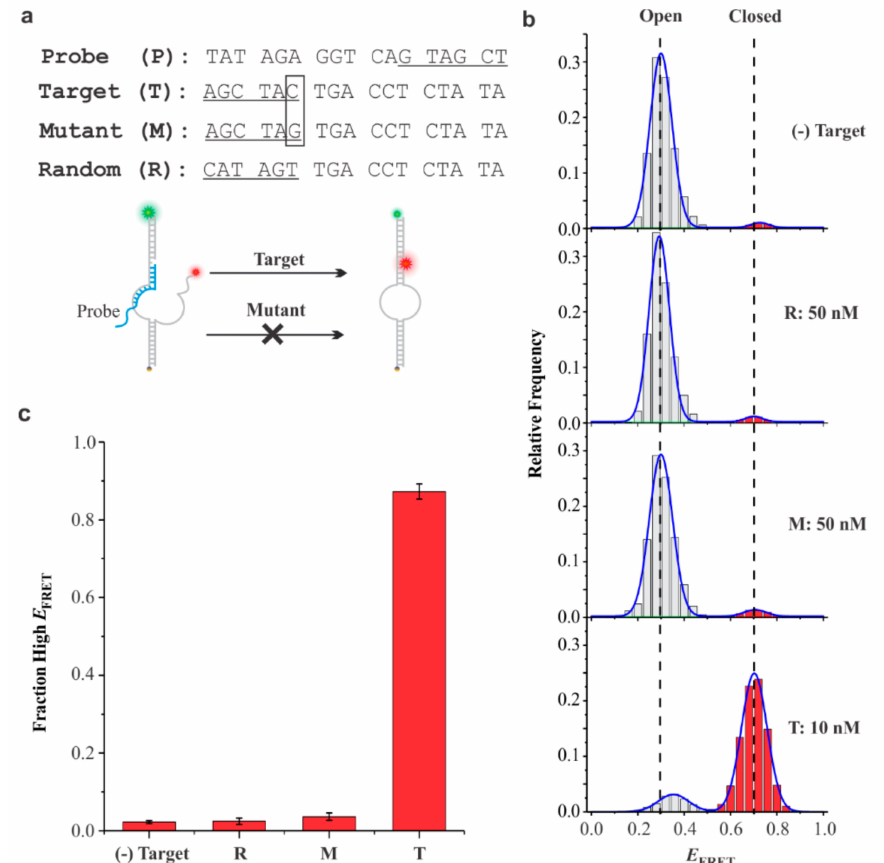
Figure 5. Discrimination of single nucleotide mismatch from fully matched target. ( a ) The sequences of probe (P), target (T), mutant (M), and random (R) used for specificity analysis using sensor-III. Target refers to perfect complementary sequence. Mutant refers to a single nucleotide mutated target, whereas random refers to a target with fully randomized toehold region. The toehold regions are underlined, and the point mutation is identified with a box. ( b ) The smFRET histogram without the target (top panel) followed by the smFRET histograms after incubation with random, mutant, and fully matched target sequences. Almost none high- E FRET population for random and single-base mismatch target demonstrated that these sequences were not able to displace the probe. The E FRET histograms were prepared from ~200 molecules. ( c ) Comparison of high- E FRET fraction under di ff erent conditions. Histogram depicts that high- E FRET fractions for both the mutant and the target were similar to the background signal (2.3 ± 0.4%). However, in the presence of the target, the high- E FRET fraction increased significantly (87%). Error bars represent the standard deviations (SD), n =